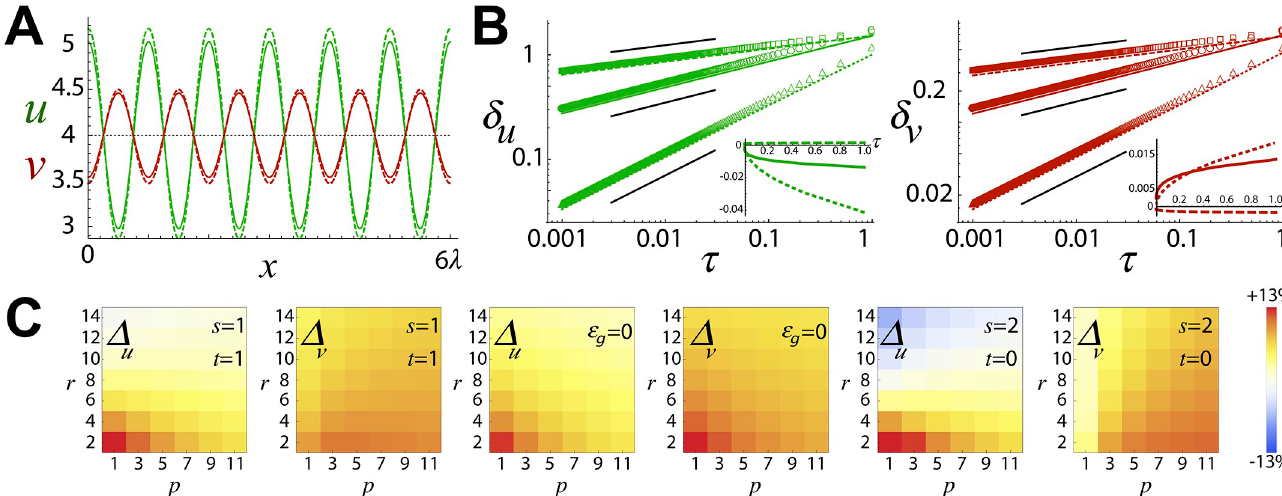
Fig 2. A : Stationary pattern solutions, u (green) and v (red), obtained by our theoretical approach (continuous lines) and in numerical simulations (dotted lines). Parameters: a = 0.9, D v = 9 (black circle in Fig 1A). B : Pattern amplitudes as a function of the nonlinear parameter, τ , for different values of p and r (log-log axes): p = 3 and r = 2 (circles), p = 3 and r = 0 (triangles), and p = 5 and r = 4 (squares). The symbols stand for numerical results and the colored lines for the analytical solutions: p = 3 and r = 2 (solid line), p = 3 and r = 0 (dotted line), and p = 5 and r = 4 (dashed line). The black solids lines are a guide to the eye and show, from top to bottom, the functions t 1 8 , t 1 4 , and t 1 2 . The insets show the relative importance of the first order correction versus the leading order of the expansion by plotting td ð 1 Þ z as a function of τ (lines codes as in the main figure). C : Quantification of the relative error, Δ z , as a function of different combinations of the values of the exponents p , r , s , and t (the rest of parameters as in panel A ). The scale bar (right) is the same for all density plots.